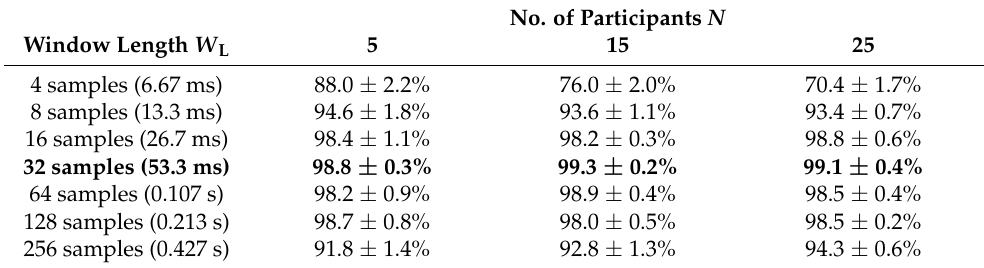
Table 1. Results for STFT spectrogram.